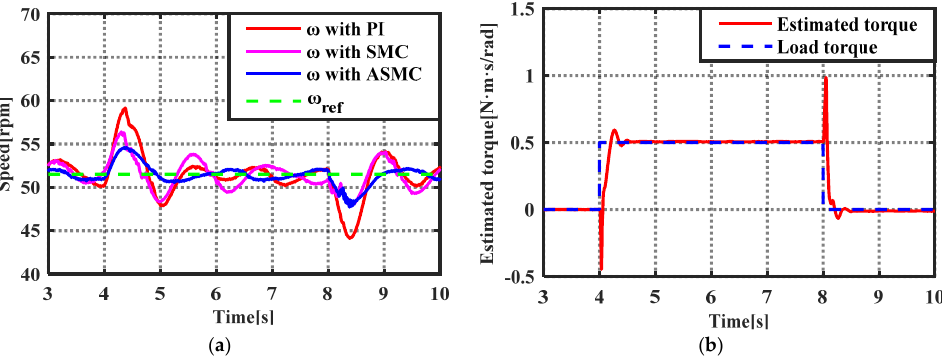
Figure 13. Experimental results of disturbance rejection with external load. ( a ) The speed tracking